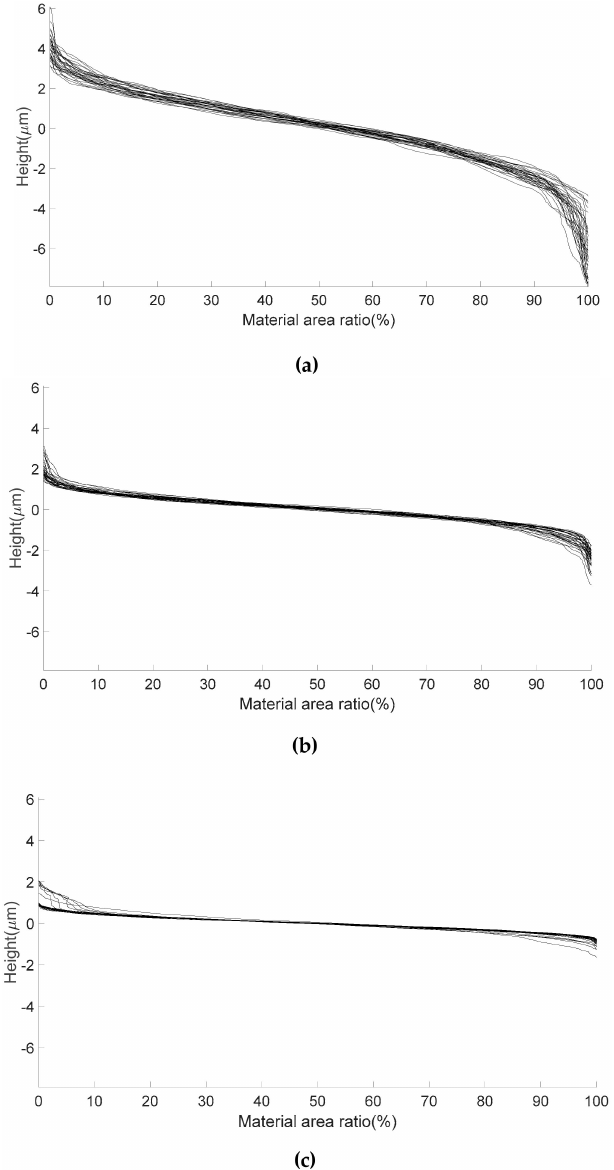
Figure 8. The bearing area curves (BAC) determined by the proposed method: ( a ) Rough (Specimen No. 1); ( b ) medium roughness (Specimen No. 2); ( c ) smooth surface (Specimen No.